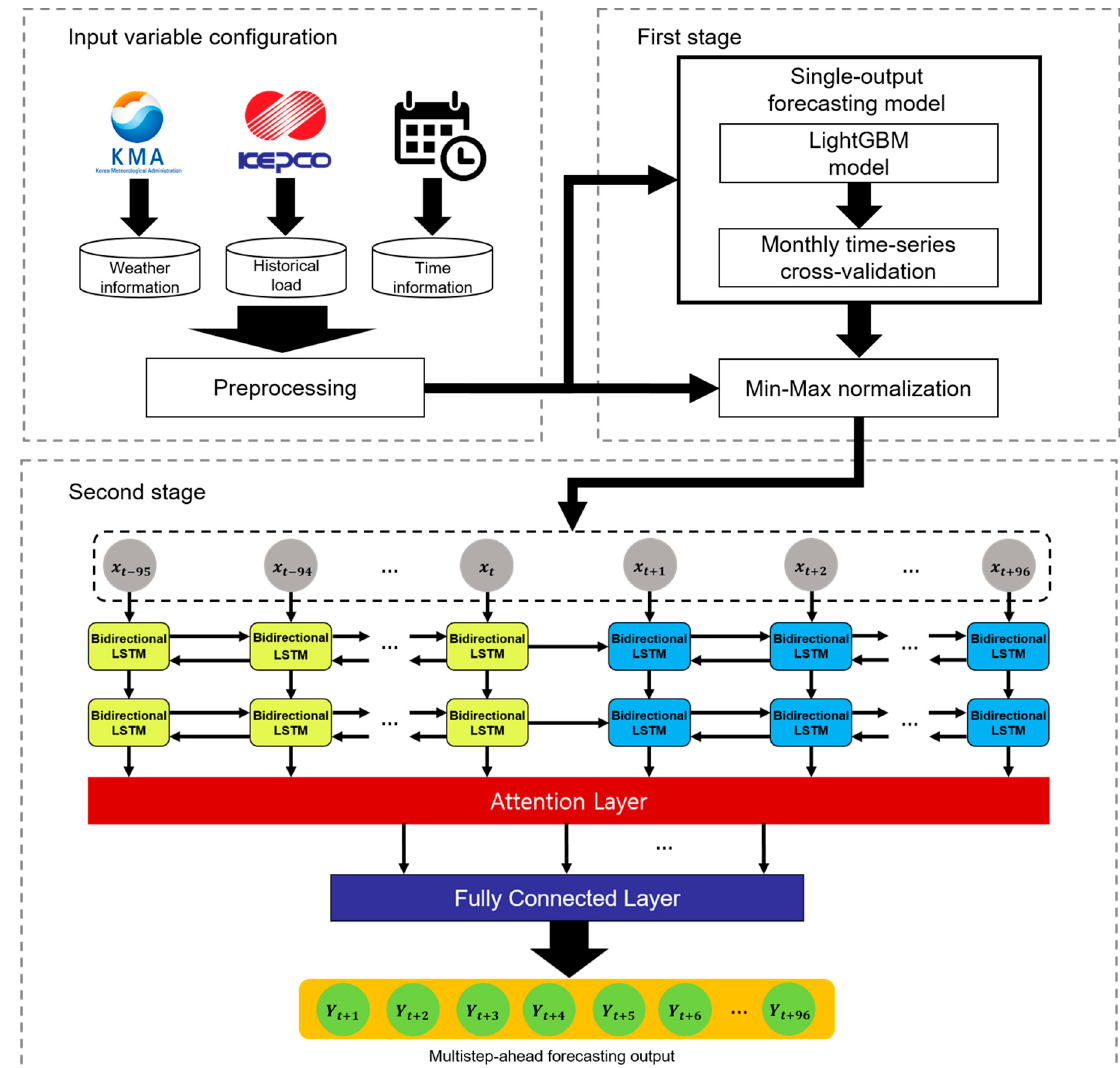
Figure 3. Architecture of two-stage multistep-ahead forecasting model.